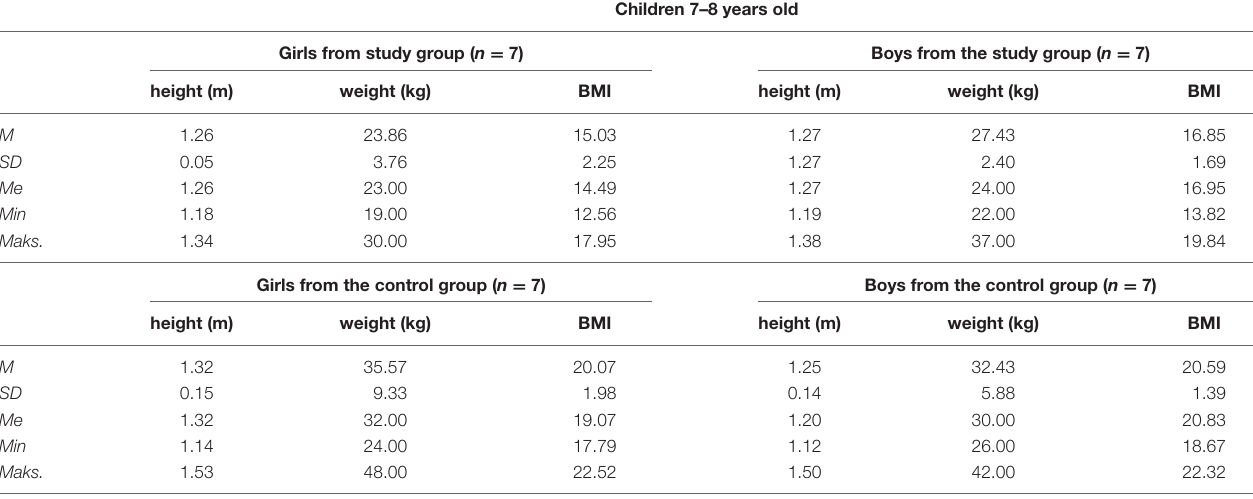
TABLE 1 | Anthropometric indicators among 7–8-year-old children depending on the occurrence of chest pain and gender.